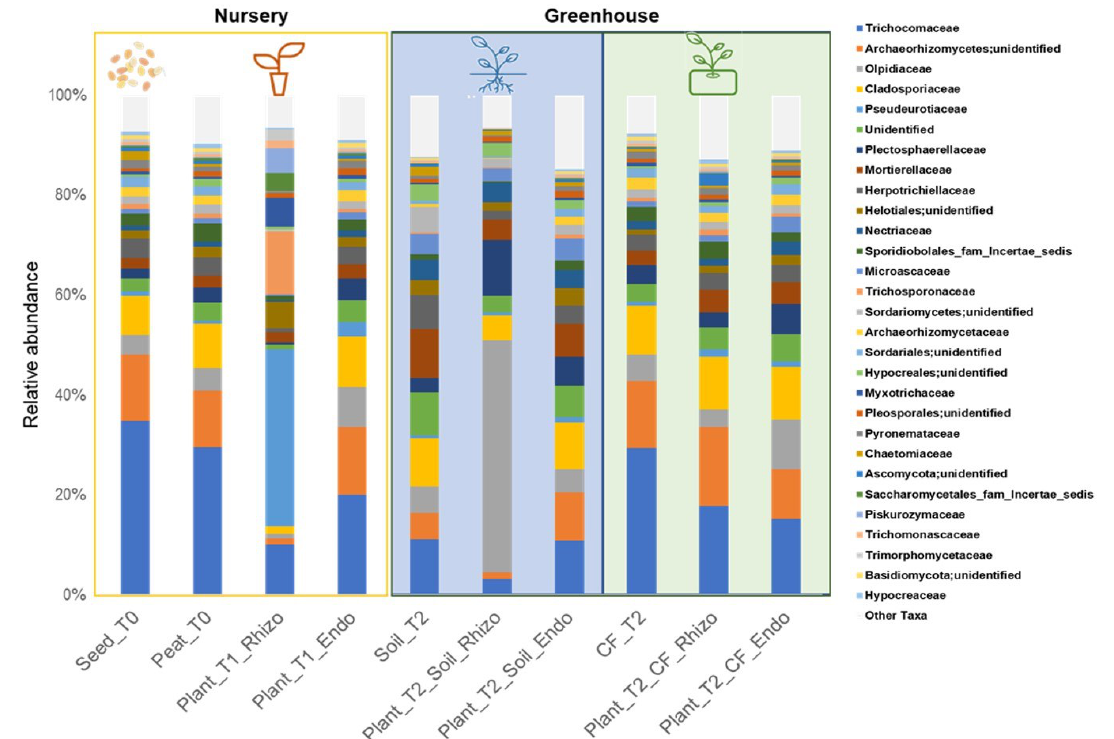
Figure 3. Distribution of fungal communities in nursery samples, seeds (Seeds_T0), peat substrate (Peat_T0) and rhizo and seedling endorhizosphere (Plant_T1_Rhizo; Plant_T1_Endo); and greenhouse, coconut fiber substrate (CF_T2) and agricultural soil (Soil_T2), rhizo and endorhizosphere of tomato plants in the two cultivation systems (Plant_T2_Soil_Rhizo; Plant_T2_CF_Rhizo, Plant_T2_Soil_Endo; Plant_T2_CF_Endo), bar charts represent fungal community composition (only key taxa have been included